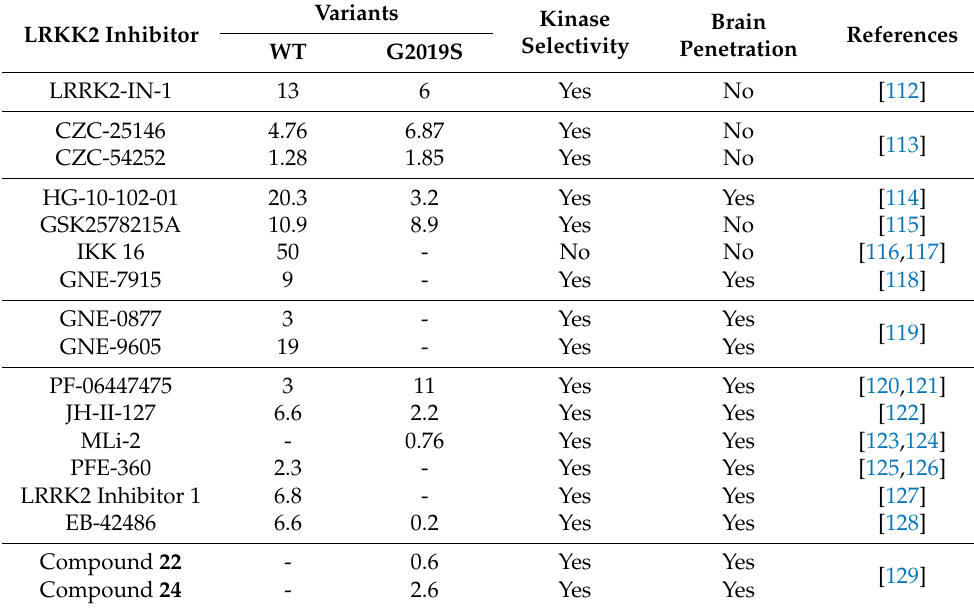
Table 1. The inhibitory activity of selected LRRK2 inhibitors against WT and G2019S, kinase selectivity, and brain penetration potential are summarized. Variants Kinase Brain LRKK2 Inhibitor References Selectivity Penetration WT